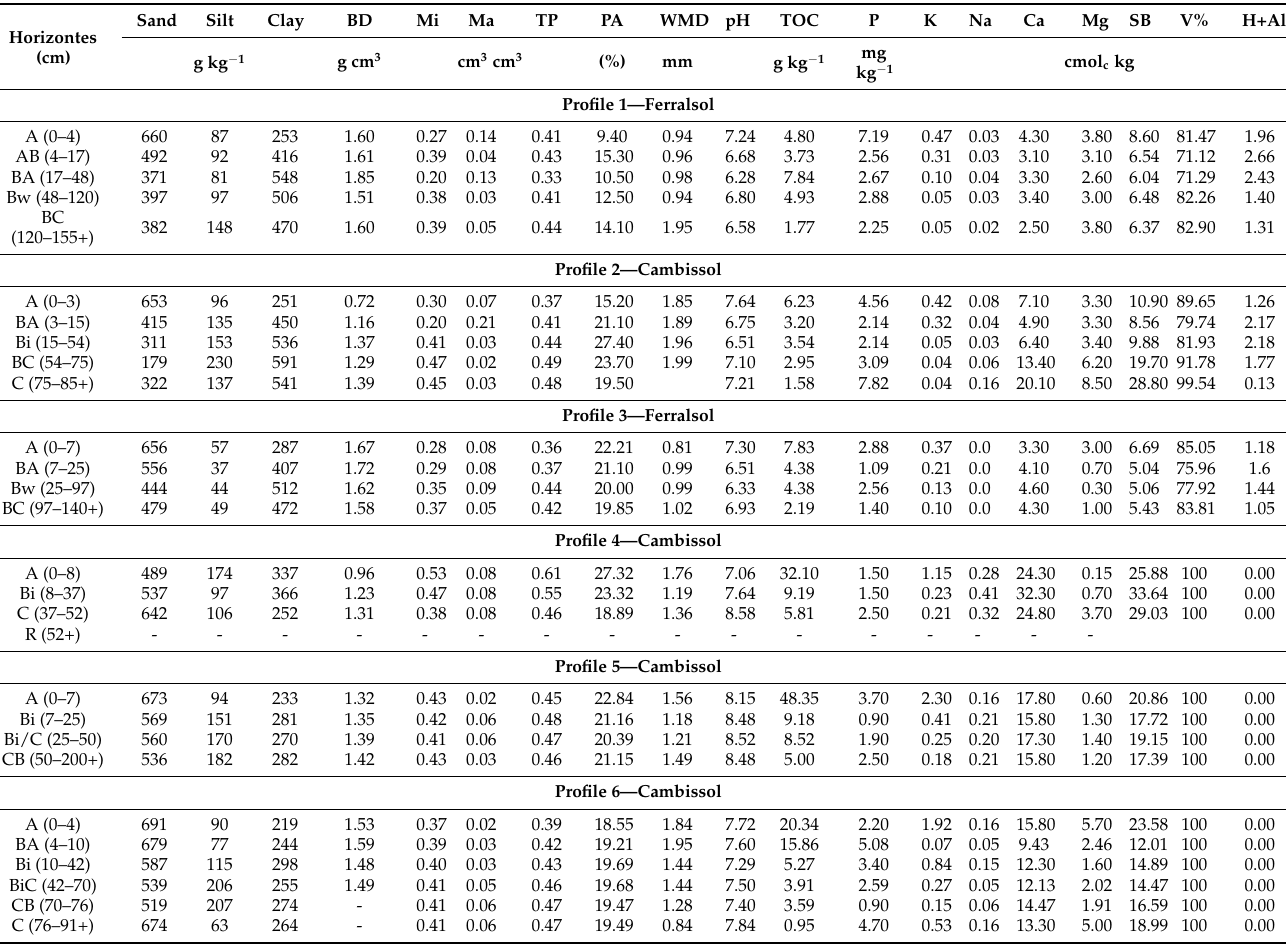
Table 4. Mean values of physical, chemical, structural and mineralogical attributes in soil classes, Apodi Plateau, Rio Grande do Norte, Brazil.